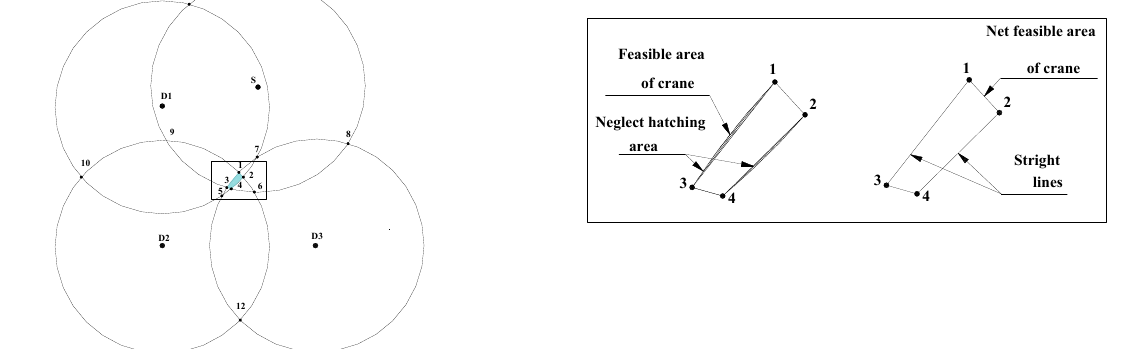
Fig. 3. Intersection locations and boundary of feasible area